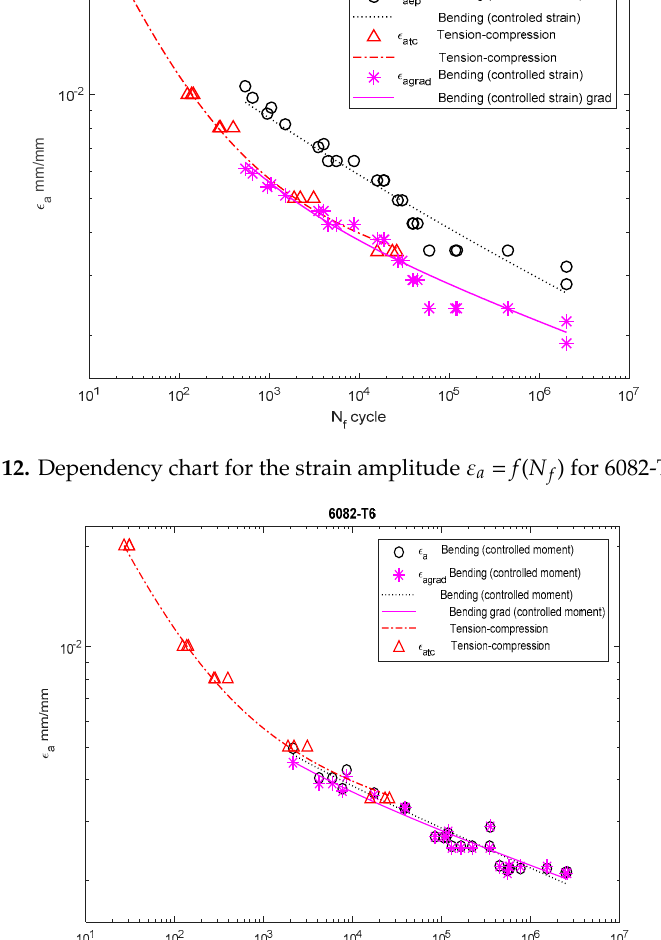
Figure 13. Dependency chart for the strain amplitude 𝜀 (cid:3028) = f ( 𝑁 (cid:3033) ) for 6082-T4 steel.